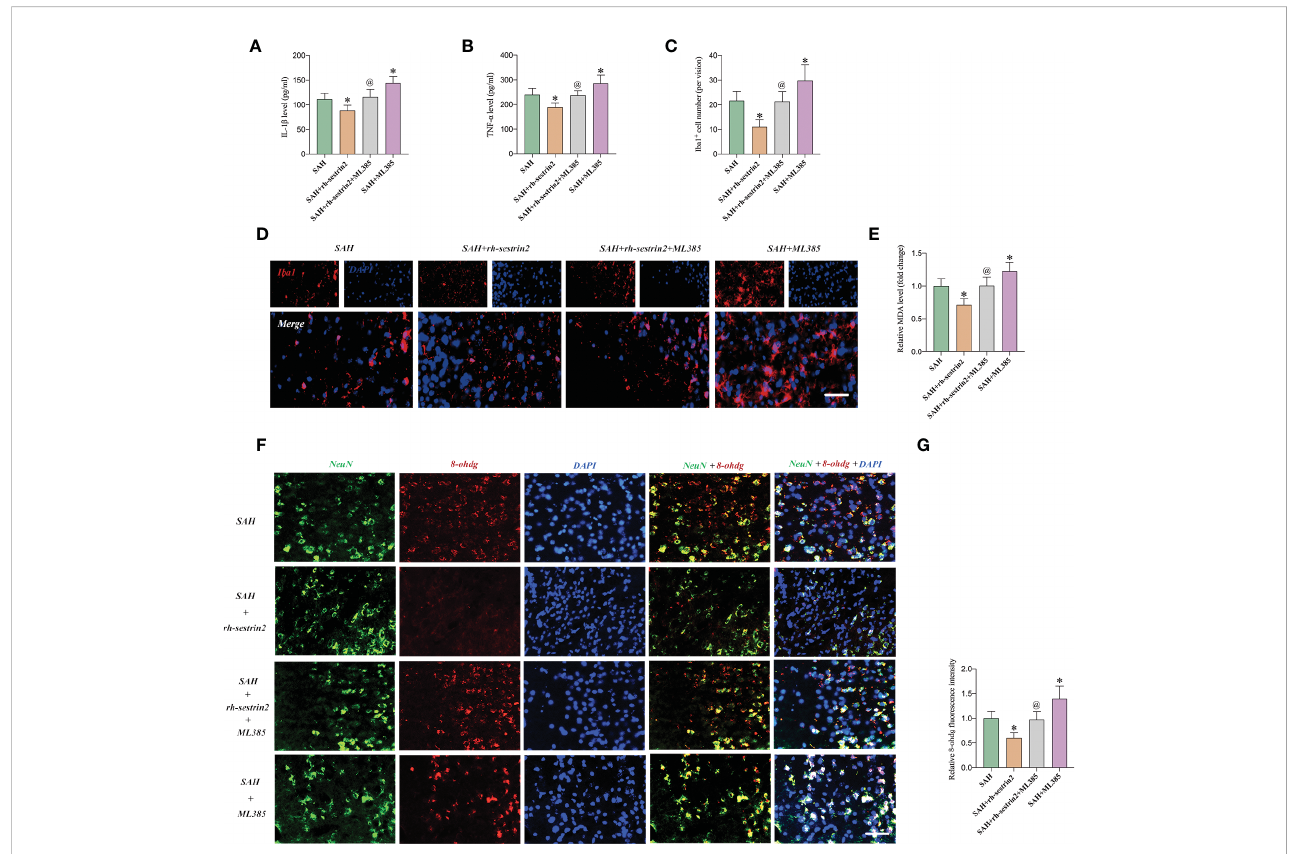
FIGURE 5 ML385 reversed the anti-in fl ammatory and anti-oxidative effects of rh-sestrin2 against SAH. Quantitative analyses of (A) IL-1 b and (B) TNF- a in different experimental groups (n = 6 per group). (C) Quantitative analysis and (D) representative images of Iba1 staining in different groups (n = 6 per group). (E) Quantitative analyses of MDA (n = 6 per group). (F) Representative images and (G) quanti fi cations of 8-ohdg staining in different groups (n = 6 per group). * P < 0.05 versus SAH group. @ P < 0.05 versus SAH + rh- sestrin2 group. Data indicated as mean ± SD. Scale bars = 50 m